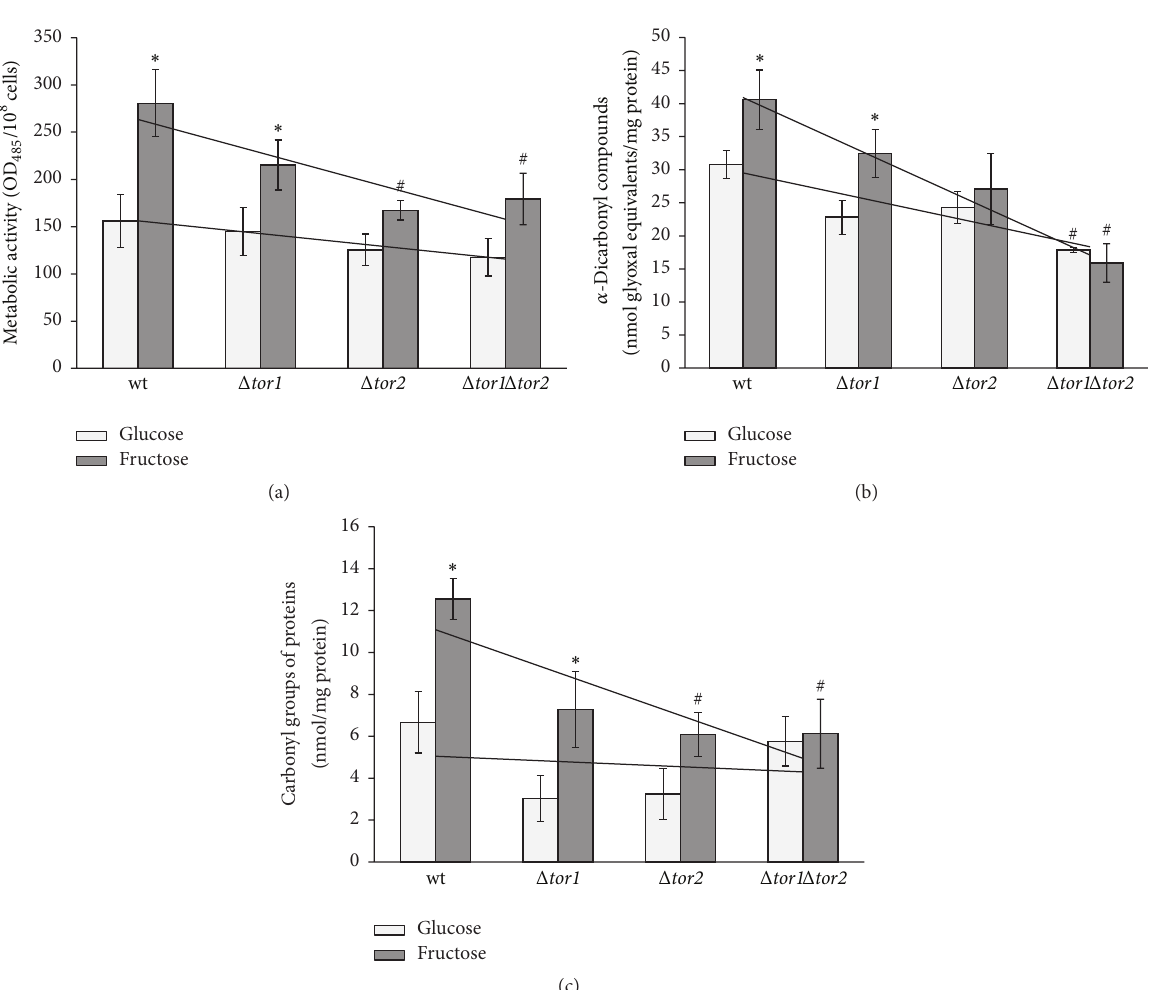
syndrome, diabetes complications, and other disturbances related to chronic consumption of diets high in